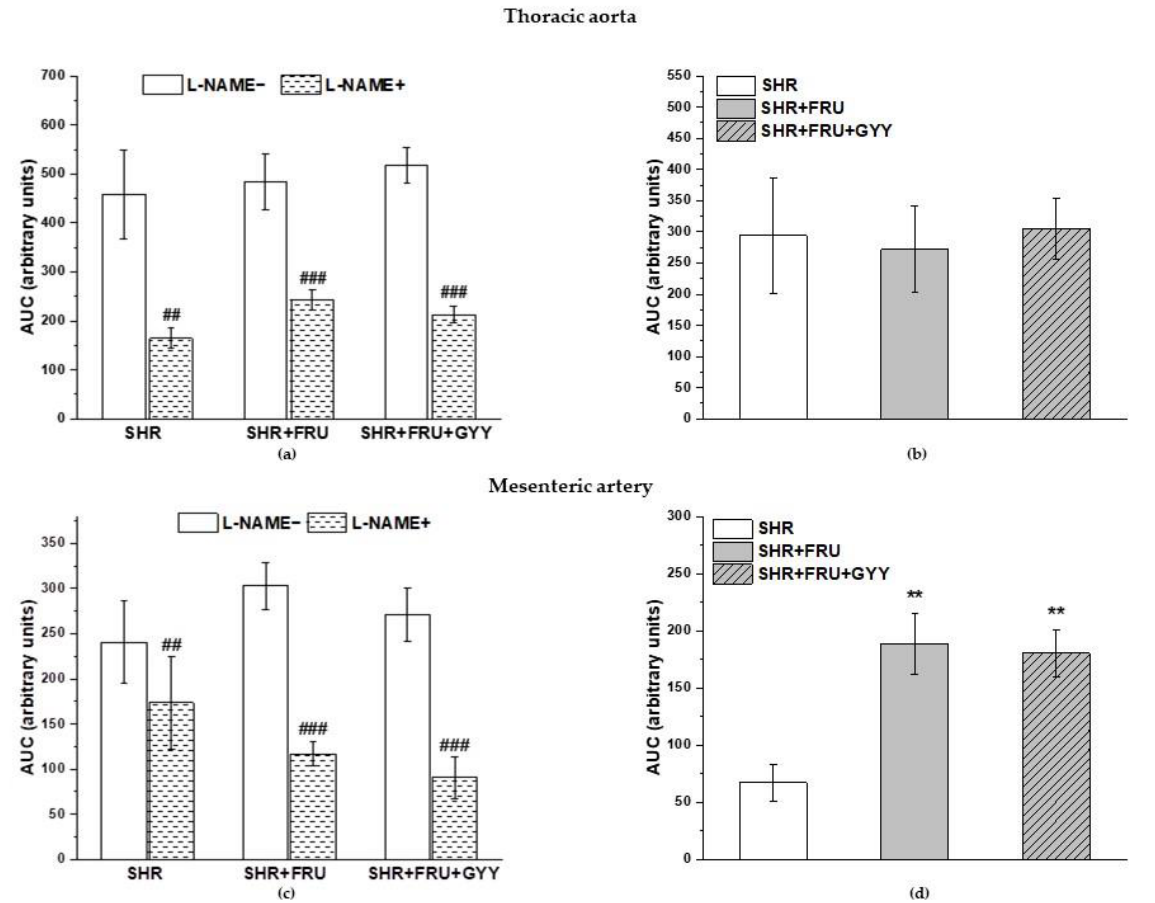
Figure 4. The participation of the NO/NOS system in the relaxant responses of thoracic aorta ( a , b ) and mesenteric artery ( c , d ). The AUC calculated before and after the pre-treatment with L-NAME in individual groups ( a , c ). The difference between the AUC before and after L-NAME — comparison among groups ( b , d ). Arteries were isolated from spontaneously hypertensive rats (SHRs), SHRs treated with fructose (SHR+FRU), and SHRs treated with fructose and GYY4137 (SHR+FRU+GYY). AUC — area under the curve, L-NAME — N G -nitro-L-arginine methylester. The data are presented as the mean ± S.E.M. Statistical analysis was performed by paired t-test or one-way ANOVA. ## p < 0.01, and ### p < 0.001 vs. control L-NAME, ** p < 0.01 vs. SHR.